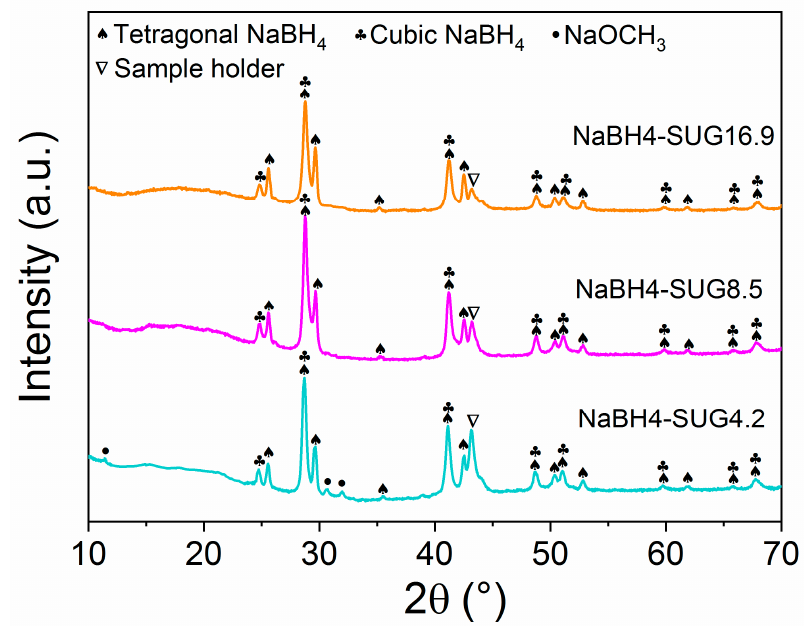
Figure 5. XRD patterns of the as-synthesised NaBH 4 via suspension-gas interaction.